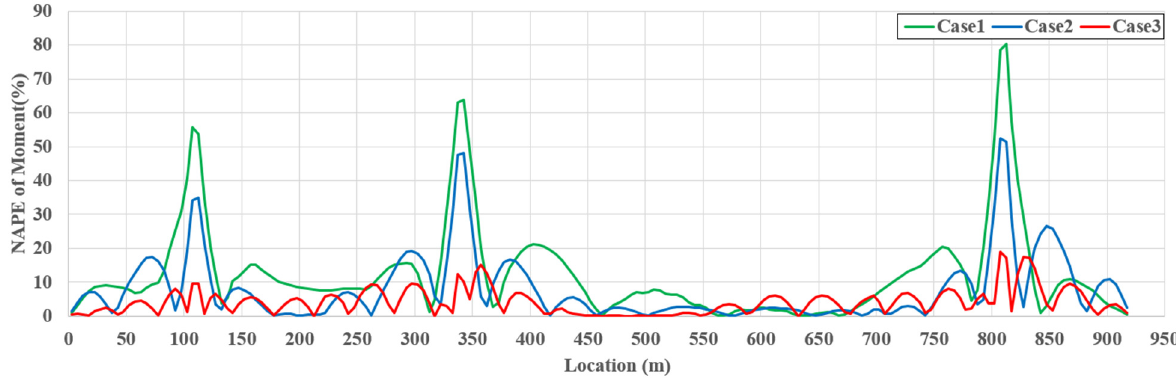
Figure 12. NAPE of estimated girder moment for TM4.